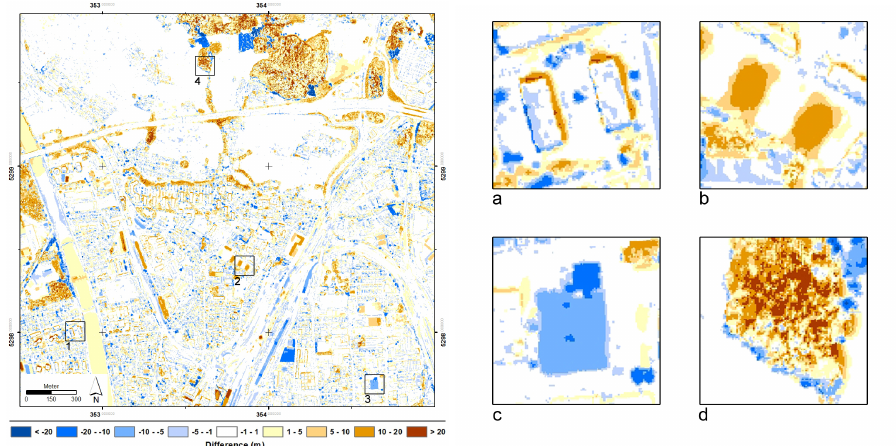
Figure 3. Left : Difference map showing height variation of the stereo-imagery DSM in comparison to the Light Detection and Ranging (LiDAR) DSM: blue colors represent areas where the stereo-imagery DSM is lower than the LiDAR DSM, brown colors denote areas where the stereo-imagery DSM is higher than the LiDAR DSM, and white areas are in the range of [ − 1/+1 m] difference; Right : Close-ups of the error map depicting ( a ) vertical residuals of the stereo DSM around buildings, ( b ) new buildings, ( c ) removed buildings, and ( d ) height differences in a small forest